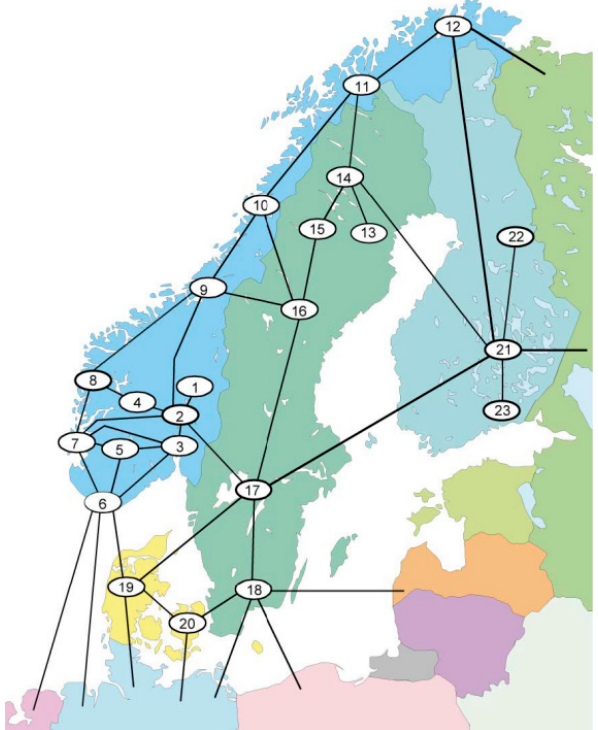
Figure 1. Simplified Nordic energy market grid as seen by EFI’s Multi-area Power market Simulator (EMPS) model. Black lines represent transmission lines among the different regions. Mid-Norway region is the region number 9. It is connected to East-Norway, West-Norway, Helgeland and Inndalselven (Sweden) regions (respectively, regions 2, 8, 10 and 16). EFI: Norwegian Electric Power Research Institute.